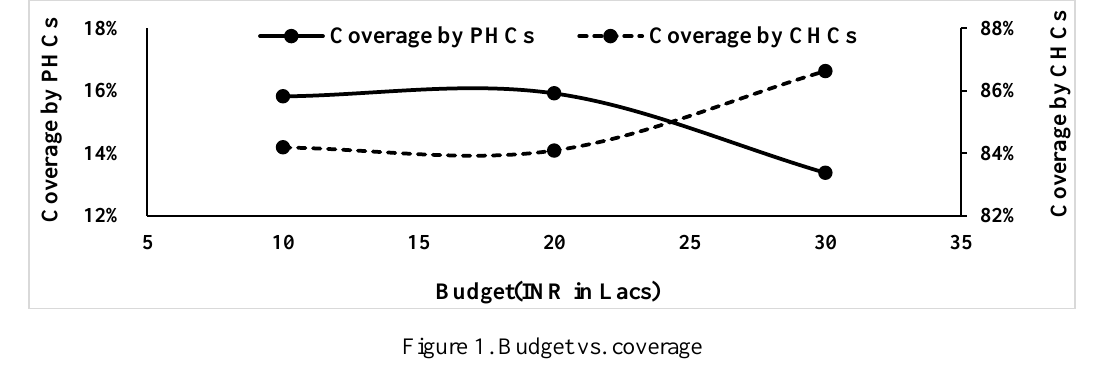
Figure 1. Budget vs. coverage